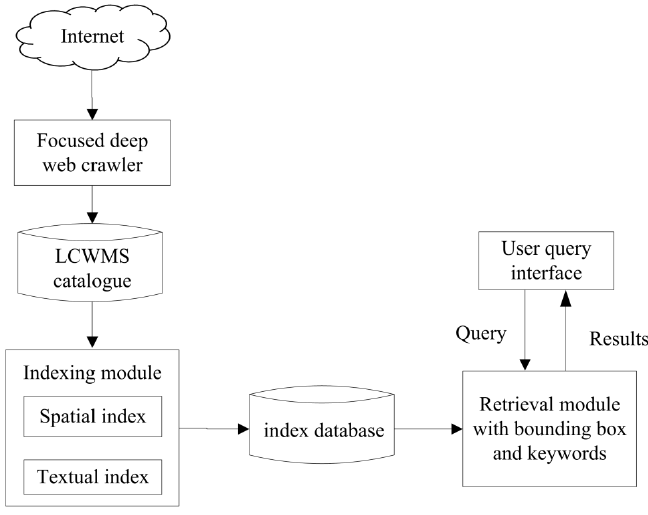
Figure 7. The LCWMS-SE architecture showing modules and linkages.